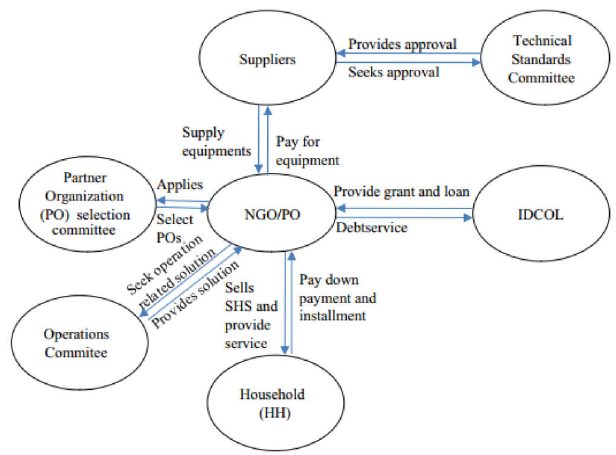
Figure 6: Institutional development for off-grid program